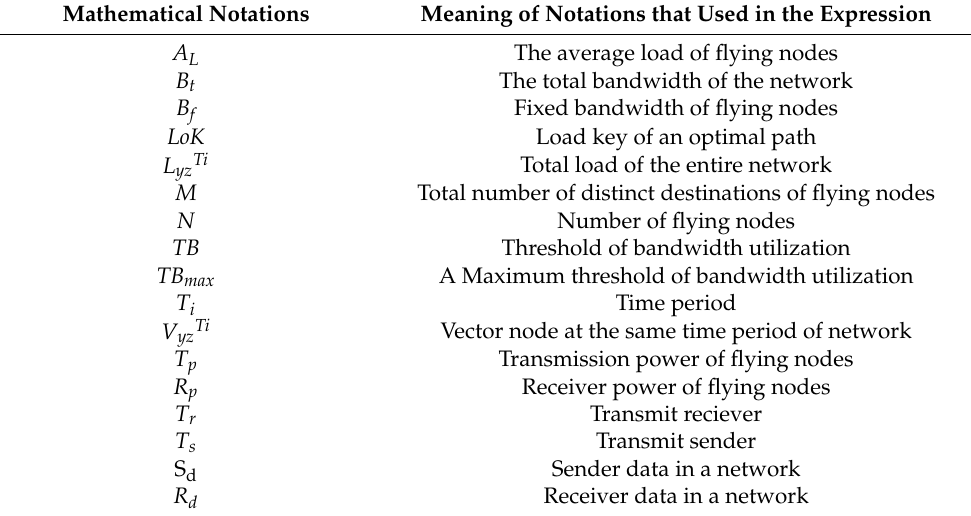
Table 3. Mathematical notations and their meaning. Mathematical